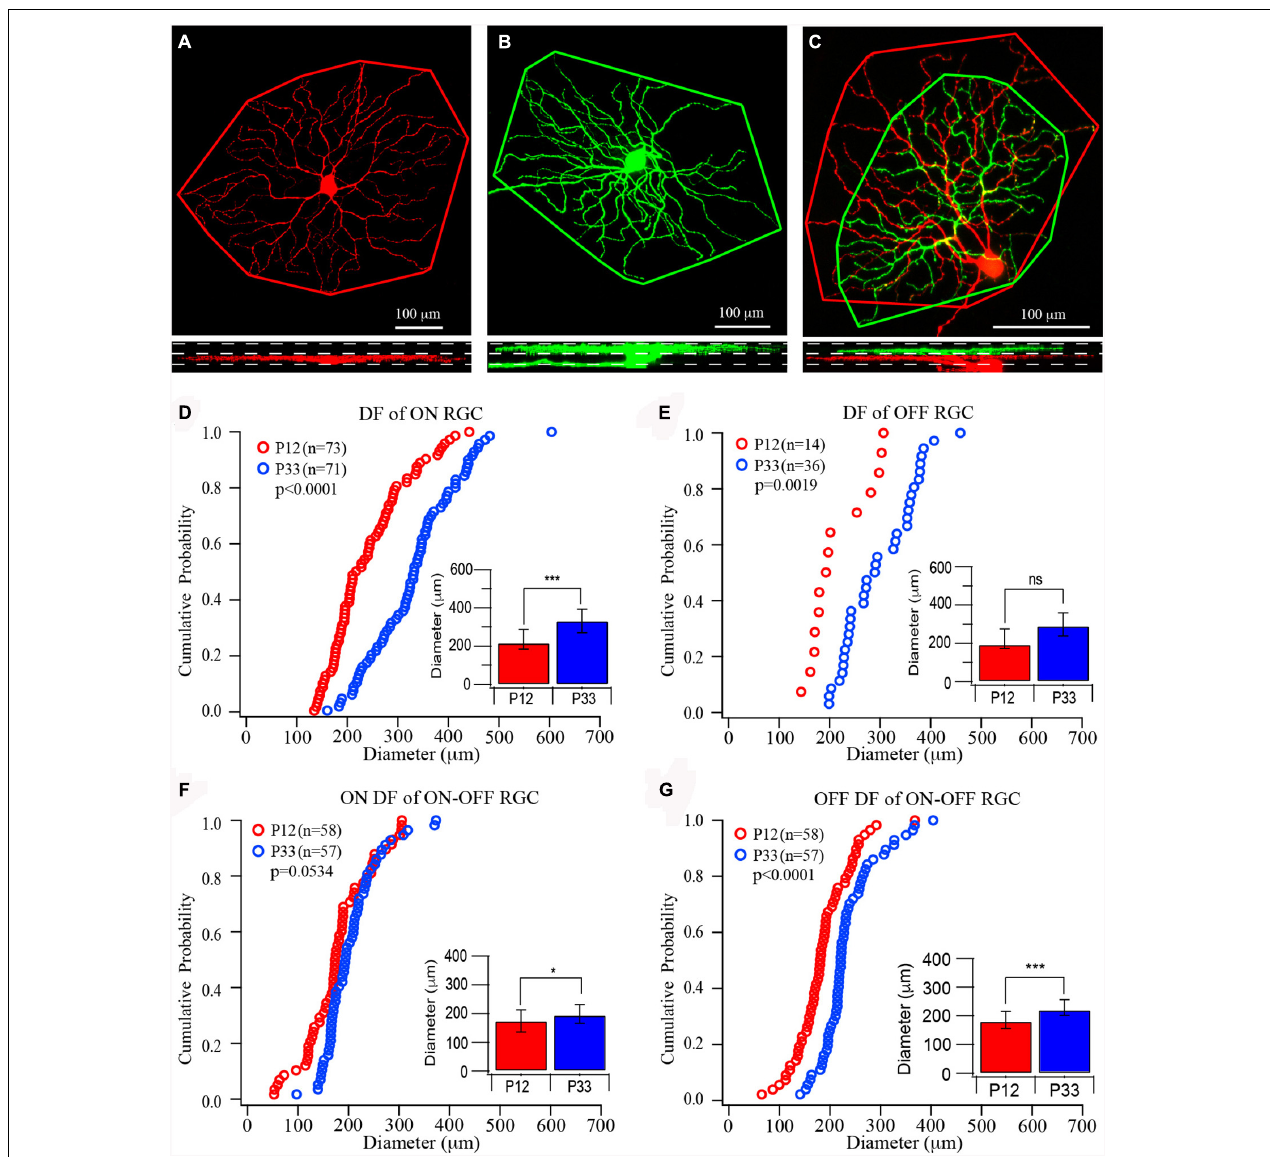
FIGURE 1 | The size of dendritic fields of retinal ganglion cells (RGCs) increases in the postnatal developing mouse retina. (A–C) Top: Representative images of the dendritic field of ON, OFF, and ON–OFF RGCs, respectively. The red color shows dendrites ramified in the ON sublamina, and green shows dendrites ramified in the OFF sublamina. Outlines are the measurement of the size of dendritic fields. Bottom: The side view of the three RCCs showing the dendritic distribution in the inner plexiform layer (IPL). ( D–G) Cumulative distribution curves of the diameter of the dendritic field of ON, OFF, and ON–OFF RGCs of P12 (red) and P33 (blue) mice, respectively. Inset: median diameter of dendritic field. Error bars in the bar graphs indicate interquartile range (IQR). A Mood’s test was used to examine the differences among two or more medians. The p values were from K–S tests of cumulative distributions. The “*” sign is used to indicate the p -value from Mood tests. *0.05 > p > 0.01; ***0.001 > p ; ns, not